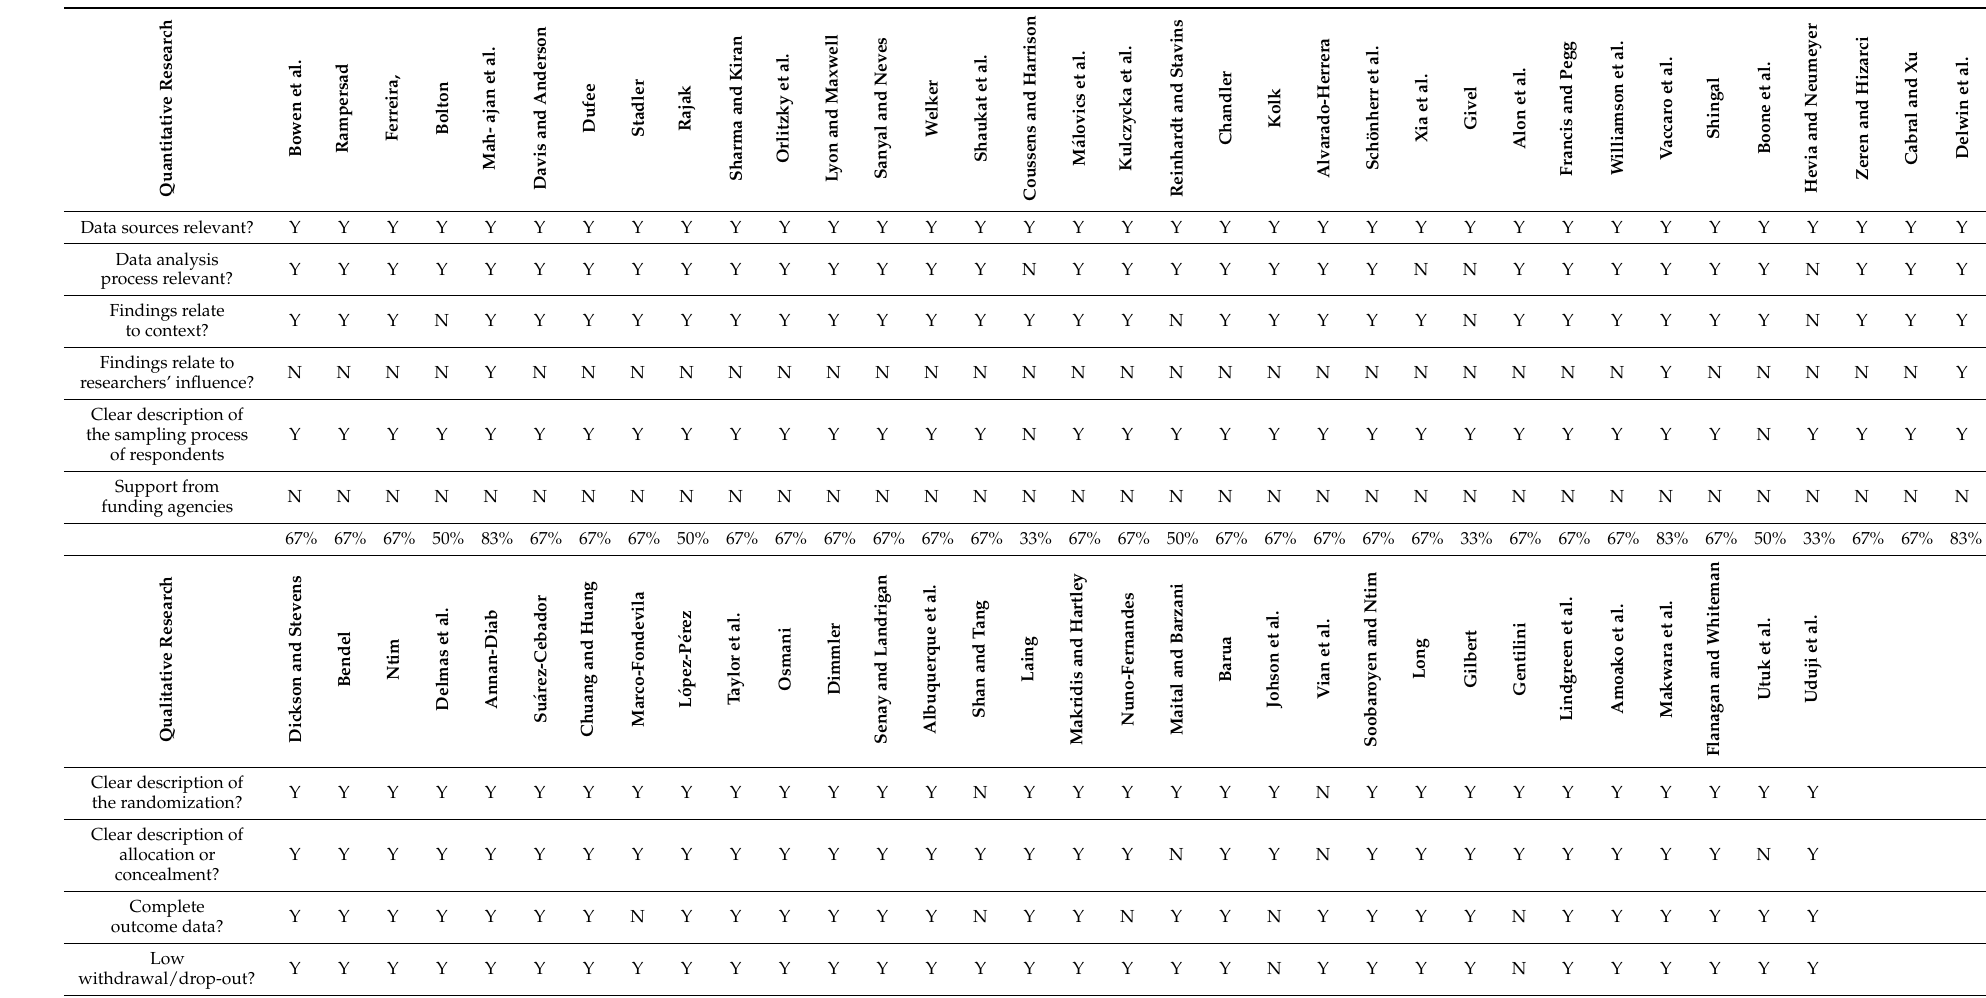
Table 3. MMAT assessment of quality of extracted articles for systematic